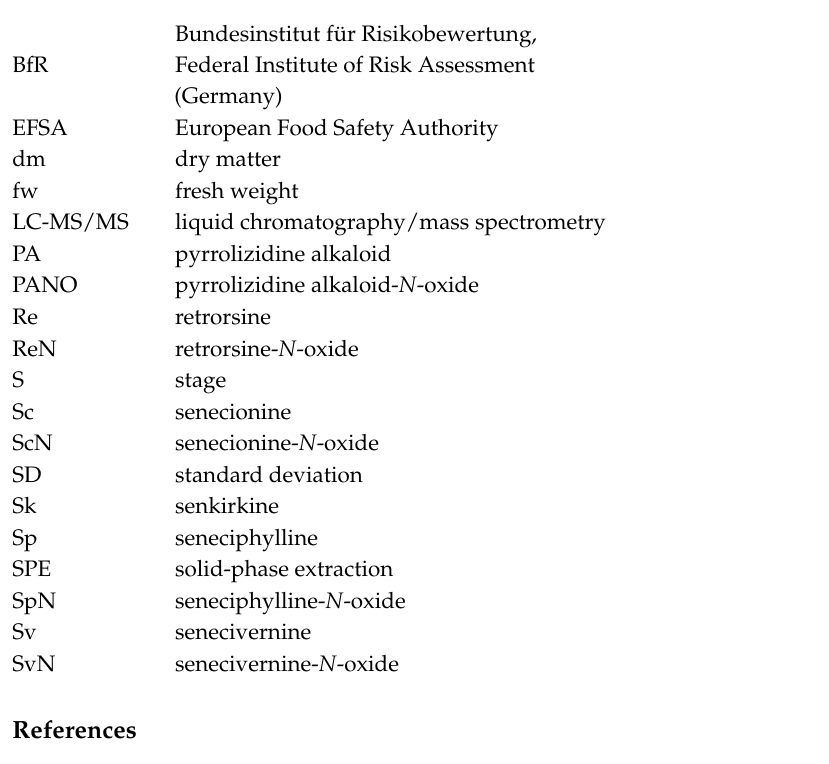
before sampling, representative pictures; B: Plants of Senecio vulgaris L. before sampling, representative pictures. Figure S4: Total PA concentration ( µ g/g) of nine different PAs in Senecio vulgaris L. plants (fresh weight) depending on the developmental stage (S1 to S5) and season. Results are means ± SD of five different determinations (distinct sub trials, see Supplemental Figure S2 and S3). Figure S5: A: Average height (cm) of Senecio vulgaris L. plants depending on the developmental stage (S1 to S5) and season. B: Average fresh weight (g) of Senecio vulgaris L. plants depending on the developmental stage (S1 to S5) and season. C: Average dry matter (g) of Senecio vulgaris L. plants depending on the developmental stage (S1 to S5) and season. Results are means ± SD of five